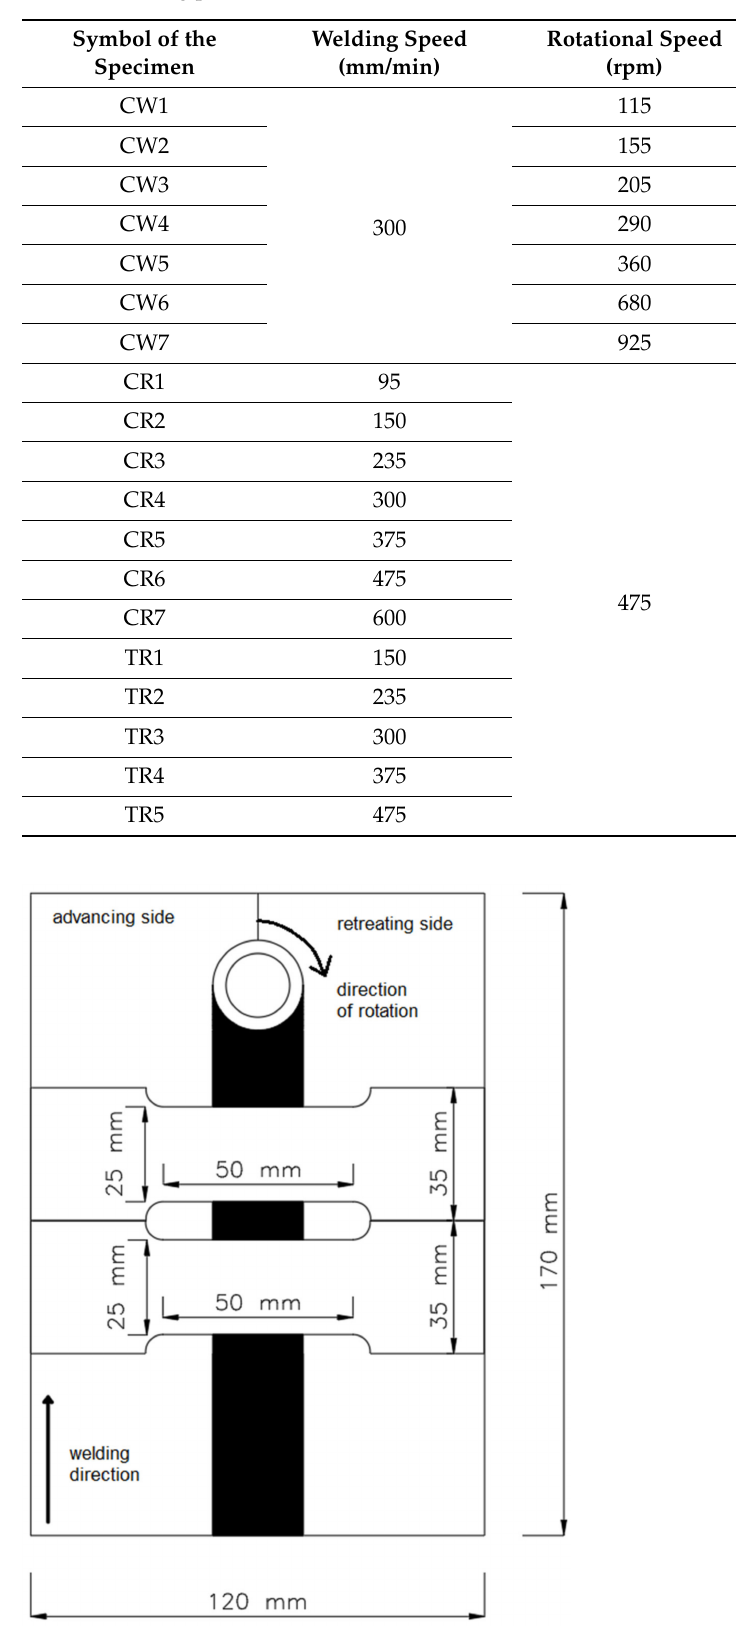
Table 2. Welding parameters.